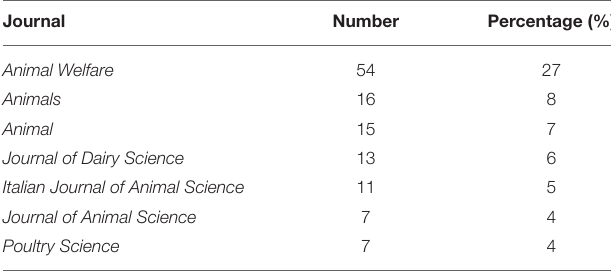
- the ratio between papers with the general ABM term (nominator) and the total number of papers on animal welfare (denominator)